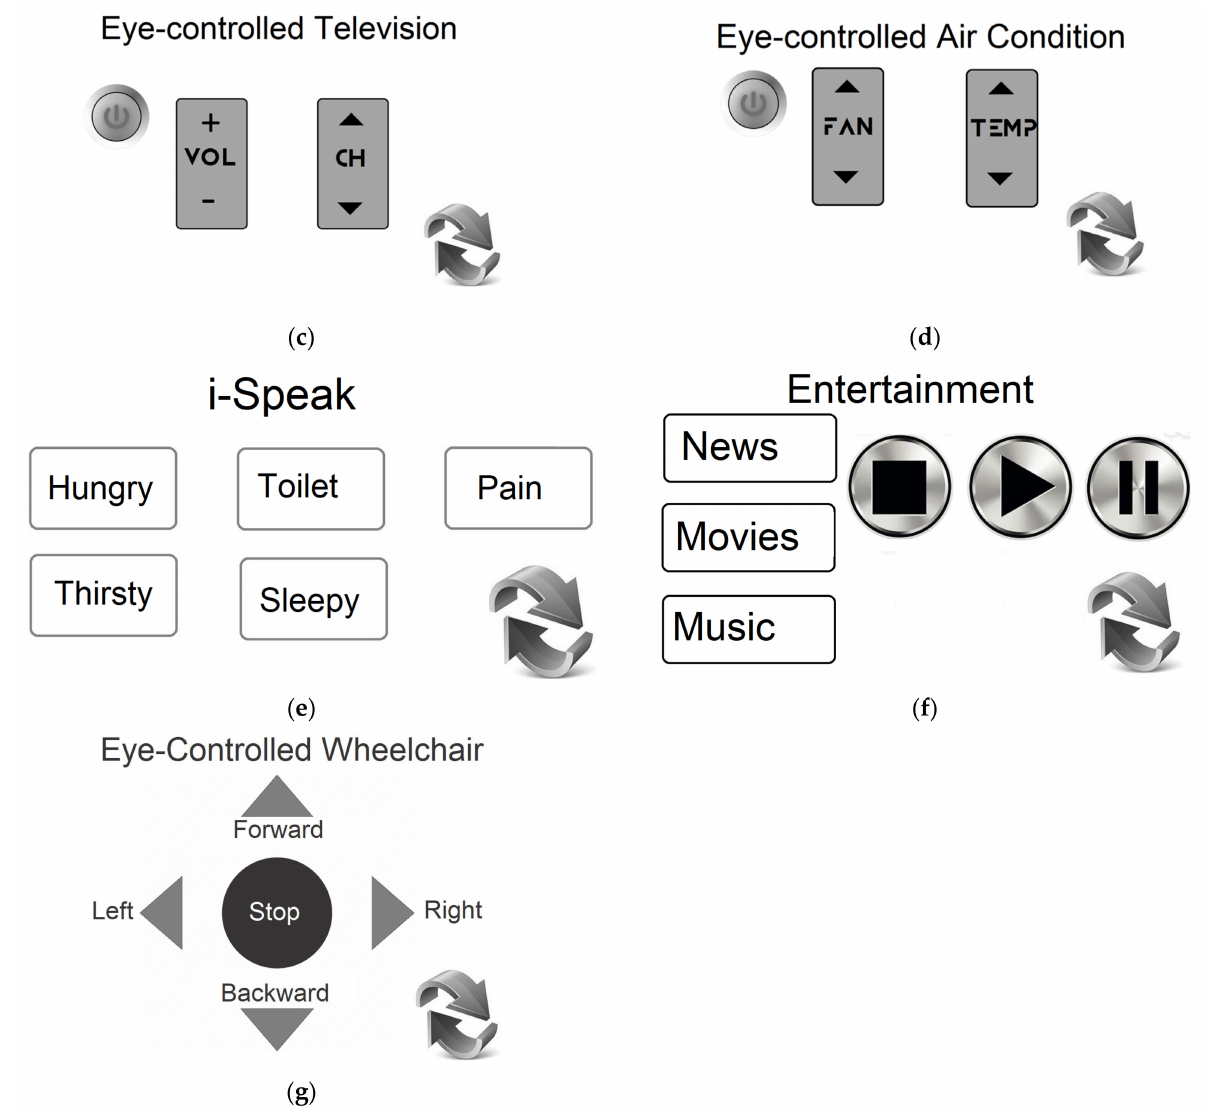
Figure 12. Graphic user interface: ( a ) home page; ( b ) smart appliance page; ( c ) eye-controlled television page;( d ) eye-controlled air condition page; ( e ) i-speak page; ( f ) and entertainment page; ( g ) eye-controlled wheelchair